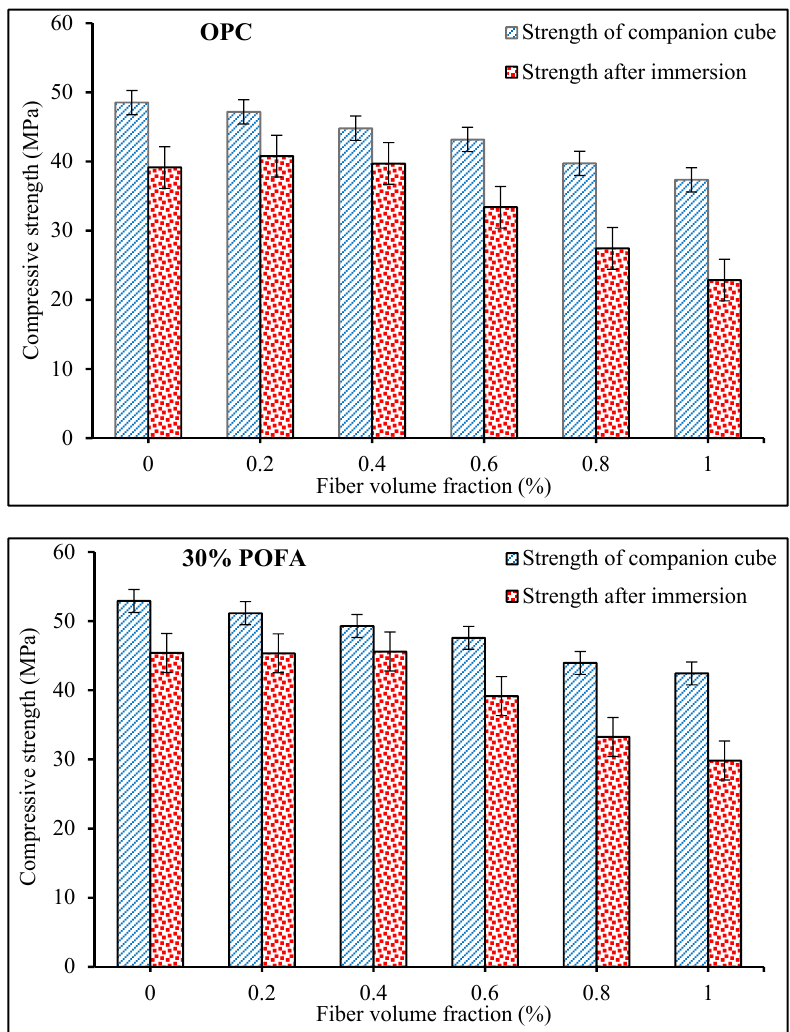
Figure 8. The variation in the 365-day compressive strength of concrete mixtures containing WPFT fibers exposed to a MgSO 4 solution.